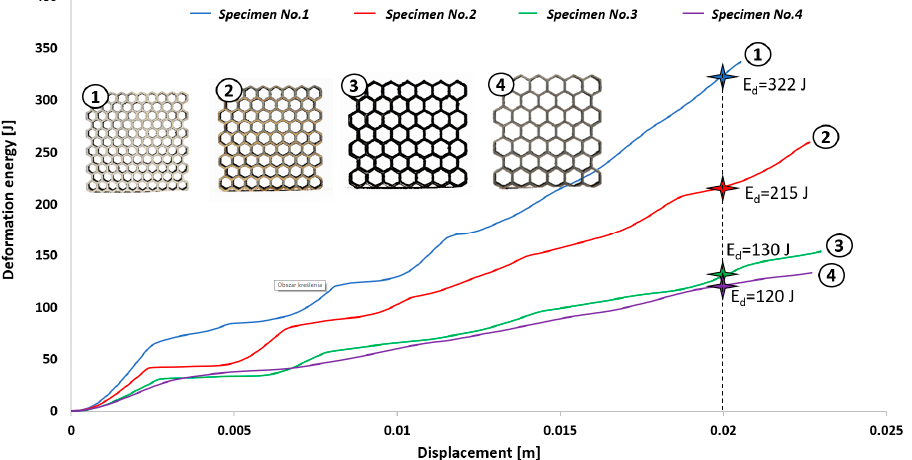
Figure 16. Comparison of deformation energy curves related to structure unit cell size (1–4—the thin-walled honeycomb structures with the different cell size). Table 5. The comparison of maximum values of absorbed energy referring to honeycomb structure specimens.